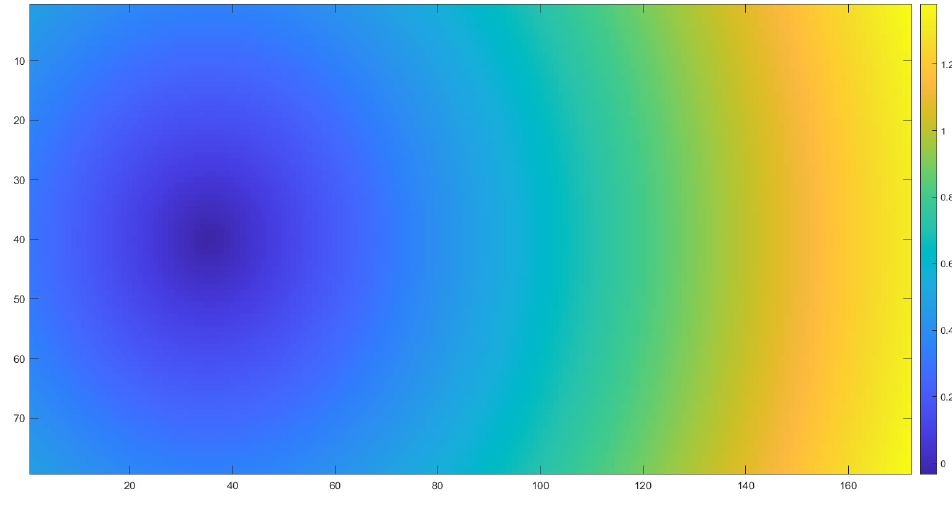
Figure 6. SDF of a circle.